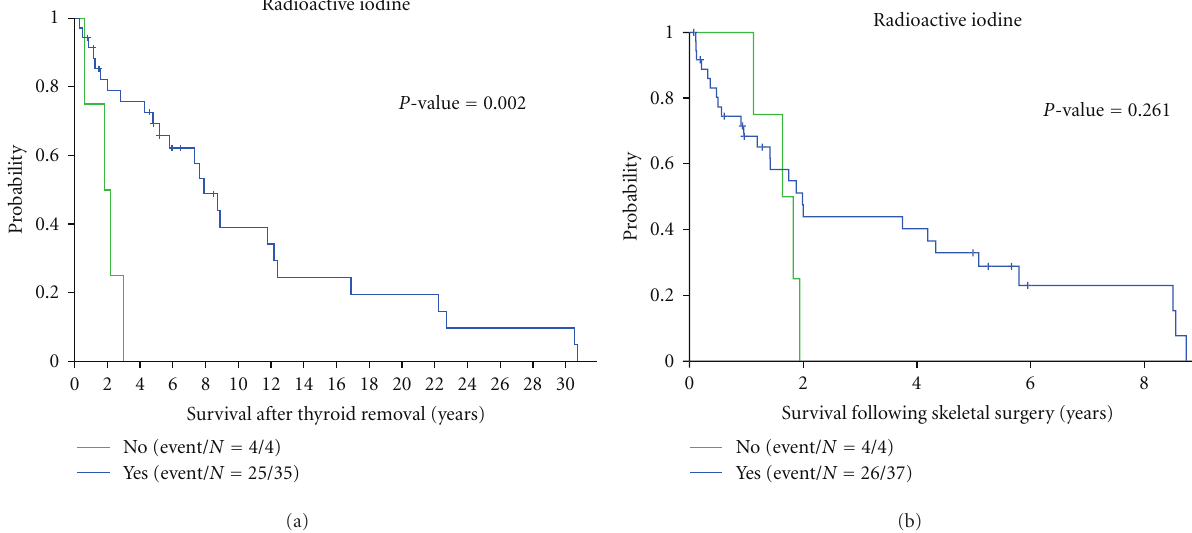
Figure 5: Kaplan-Meier analysis of the e ff ect of radioactive iodine treatment on survival. (a) After thyroidectomy, patients treated with radio- active iodine had more favorable survival than those who were not candidates for radioactive iodine ( P = 0 . 002). No patients who were not treated with radioactive iodine survived more than 3 years. (b) After surgery for osseous metastasis, there was no significant di ff erence in survival between patients treated with radioactive iodine and those who were not ( P = 0 .